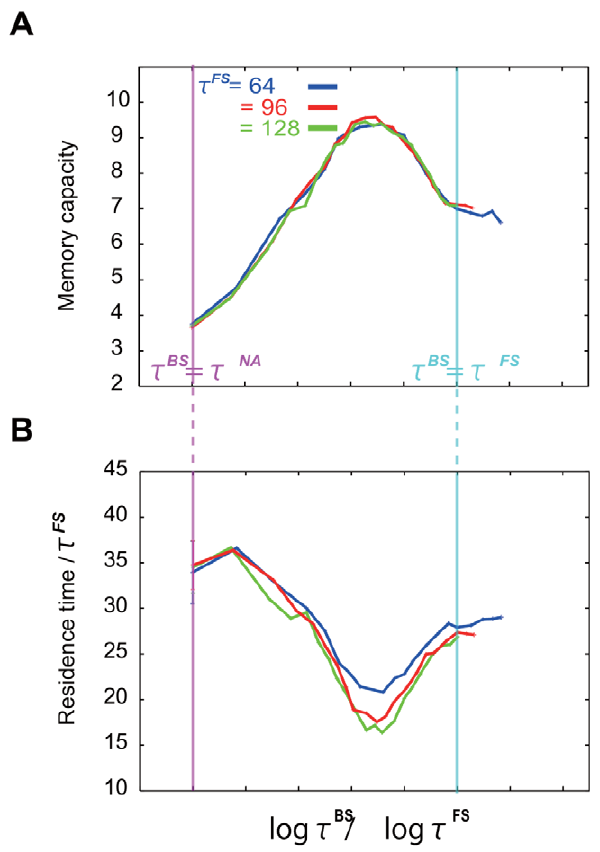
Figure 5. Scaled capacity curve and residence time curve. Scaled capacity curve (i) and residence time curve (ii) when t FS is large (64, 96, and 128) are plotted. Capacity and residence time are plotted as functions of the ratio of the logarithms of t BS and t FS and not as functions of the logarithm of t BS . Here, the residence time is scaled by t FS . Vertical pink and blue lines represent the values of t BS satisfying the conditions t BS ~ t NA and t BS ~ t FS respectively. All capacity curves show a peak at the same value of log t BS = log t FS , where the residence time takes the minimum value. Here the residence time is defined as the time at which the output neural pattern is closer to the given target than the threshold distance. To be specific, we set the threshold distance between the output and target at 0.9.